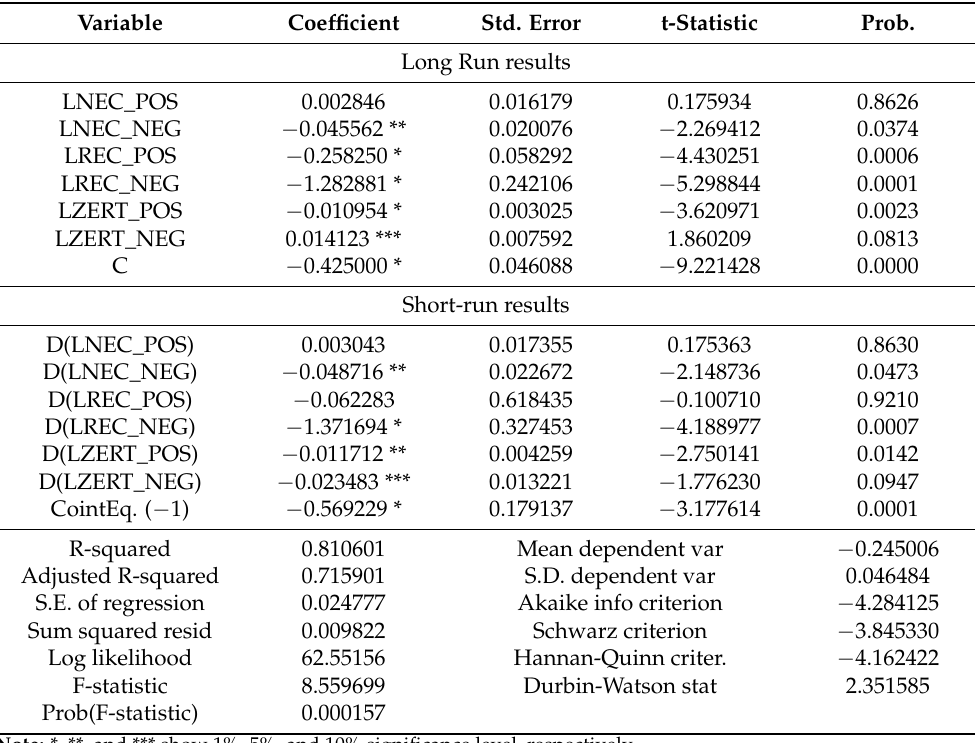
Table 10. Findings of NARDL test [NARDL (1, 0, 0, 0, 0, 0, 1)]. Variable Coefficient Std. Error t-Statistic